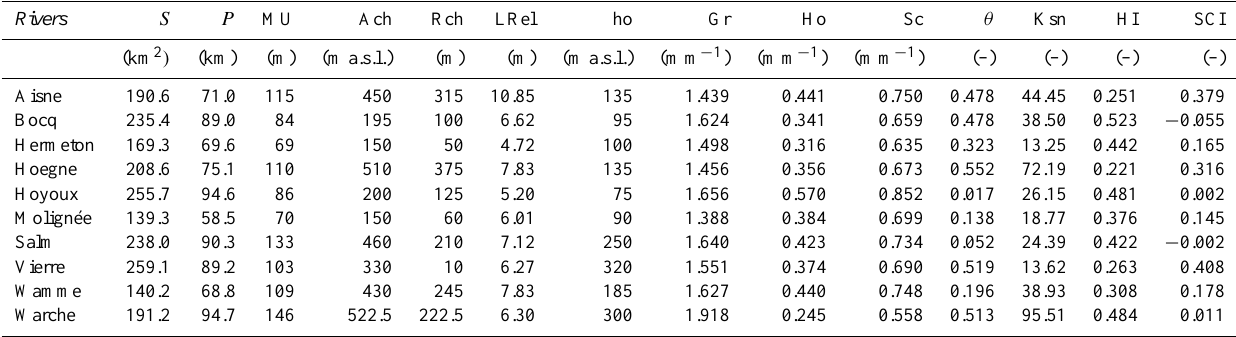
Table 1. Morphometric indices: S = surface; P = perimeter; MU = mean uplift (according to Demoulin and Hallot, 2009); Ach and Rch = the absolute and relative height of the convexities (in meters); LRel = the median of the local relief in a 100 m range window; ho = the altitude of outlet; Gr, Ho and Sc = the classical morphometric indices (Gravelius, Horton and Shumm); θ and Ksn = convexity and normalised steepness indices (Flint law); HI = the hypsometry integral; and SCI = the stream convexity